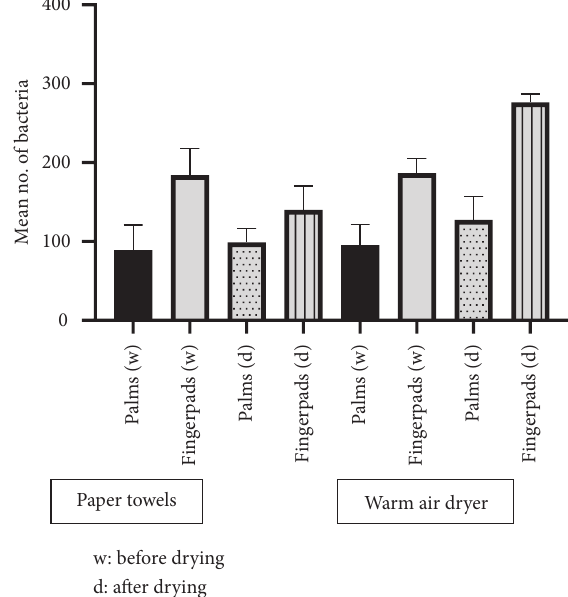
Figure 1: The mean number of bacteria obtained from the par- ticipants’ hands upon washing and drying using paper towels and warm air dryer.